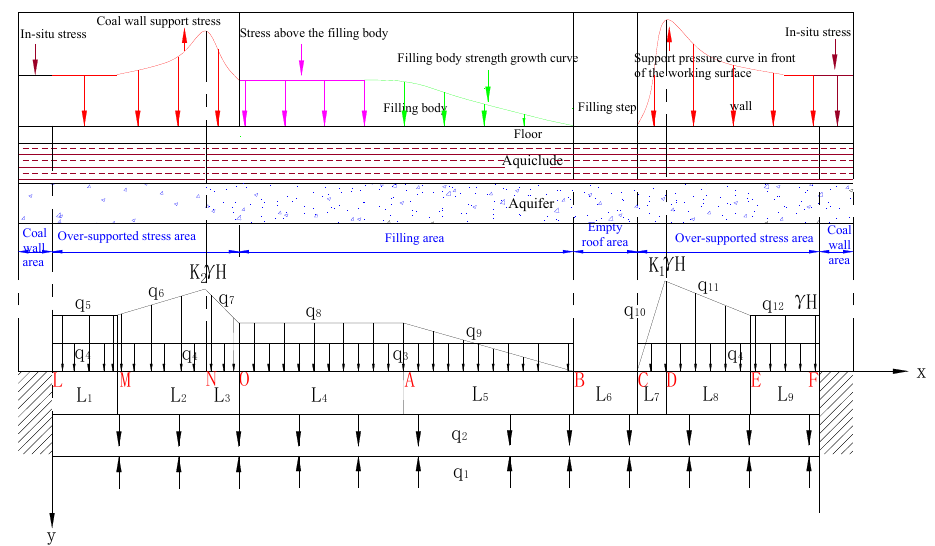
Figure 2. Analysis model of overburden state and floor stress of paste-filling face.